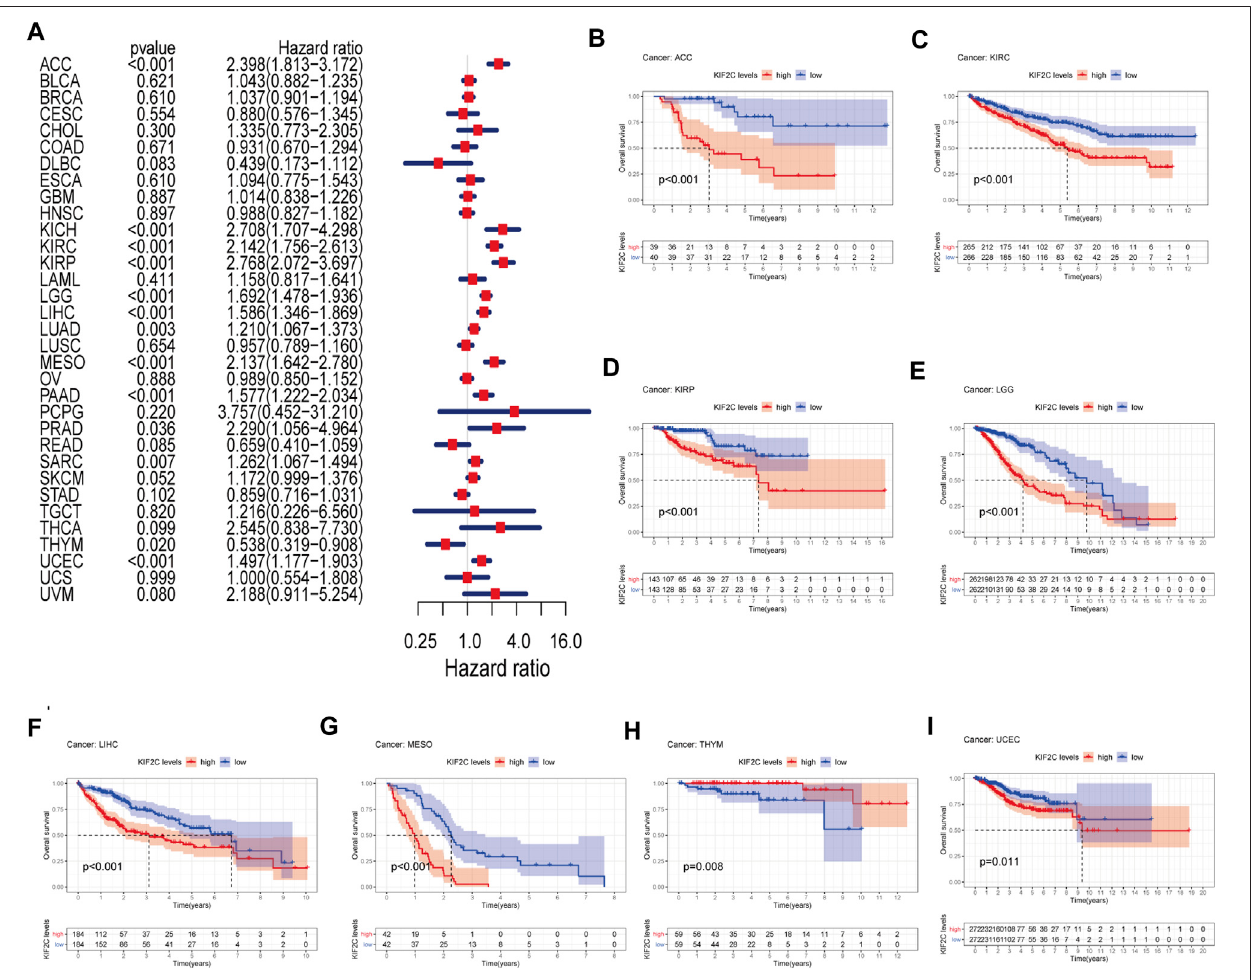
FIGURE2| OSanalysis ofKIF2C inpan-cancer (A) Forest plotshows hazard ratios ofKIF2C inpan-cancer. (B – I) Kaplan-Meiersurvival curves ofpan-cancer with high and low KIF2C expression analysed by the TCGA database.